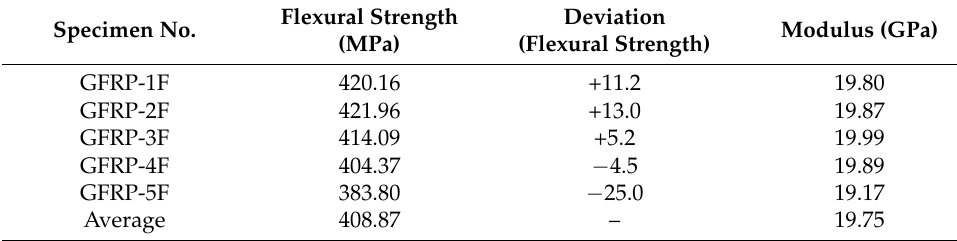
Table 3. Mechanical properties of flexural